Question: Sum up the contents of this chart in one sentence.
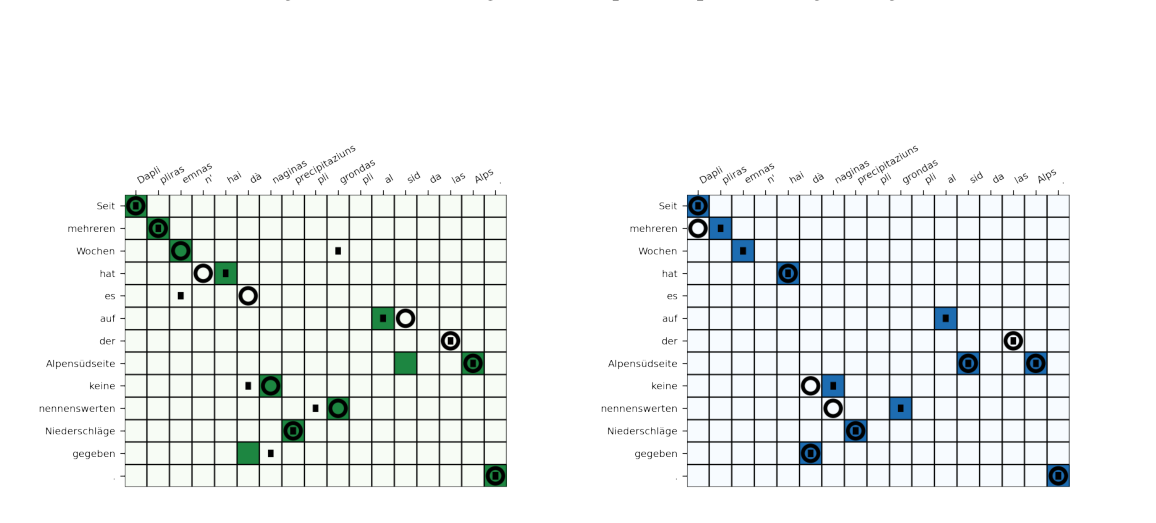
Answer: Example for aligning a sentence with differing word order. Green: eflomal (boxes) vs. SimAlign (circles); Blue: awesome-align (circles) vs. after fine-tuning (boxes). The dark green/blue squares represent the gold alignments.